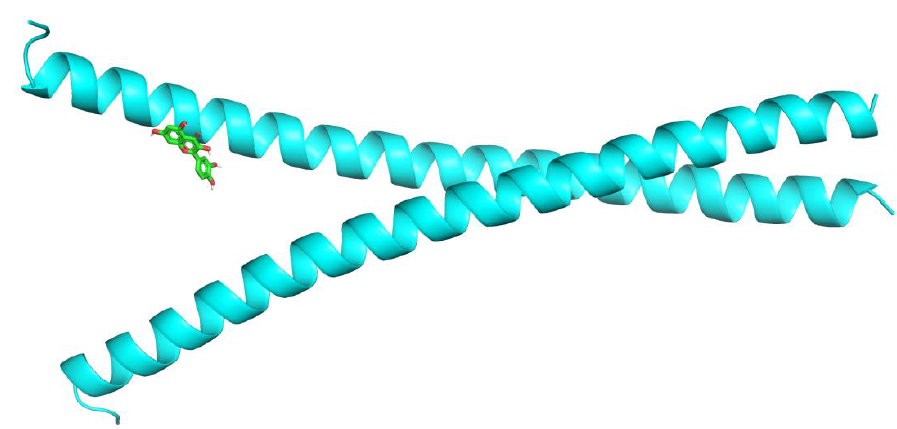
Figure 8. The docking diagram of JUN and quercetin.